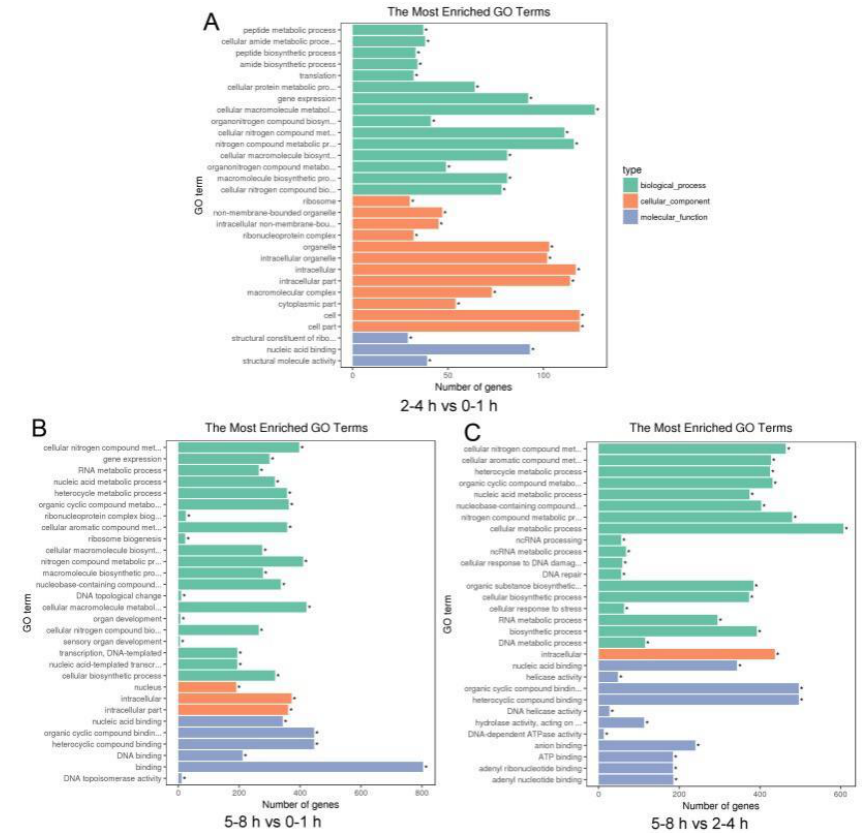
Figure 4. Gene Ontology (GO) terms classification for differentially expressed unigenes (DEGs) during the early embryo transcriptomes of B. dorsalis . ( A ) GO significant enrichment analysis for the DEGs between 2–4 and 0–1 h. ( B ) GO significant enrichment analysis for the DEGs between 5–8 and 0–1 h. ( C ) GO significant enrichment analysis for the DEGs between 5–8 and 2–4 h.